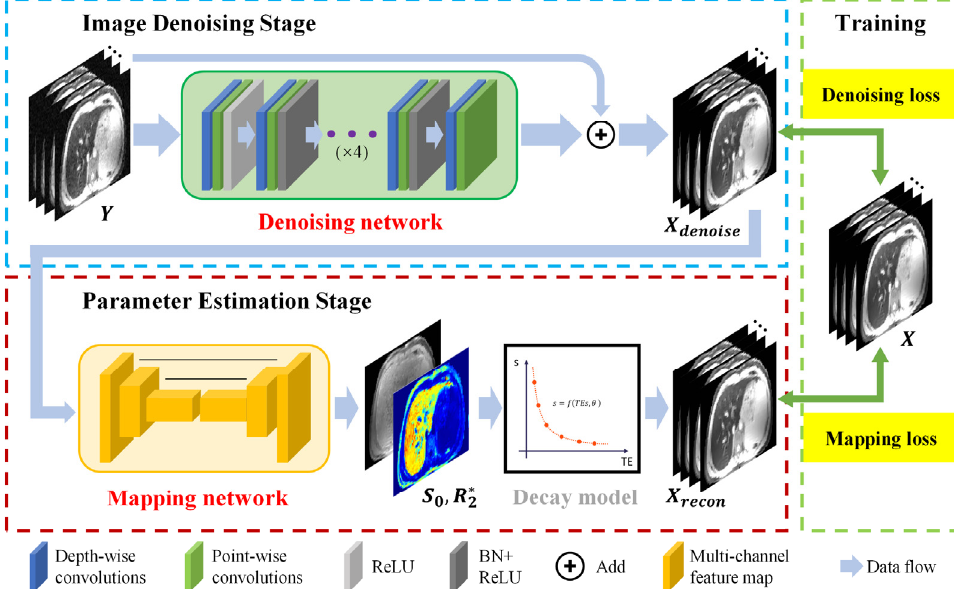
Figure 1. Overall architecture of the proposed CadamNet framework. Blue box: image denoising stage, the inputs to the denoising network are 12 images (12 echo times). The outputs are 12 denoised images. Red box: parameter estimation stage, the mapping network estimates S 0 and R2* maps from the denoised images. Green box: the losses used for network